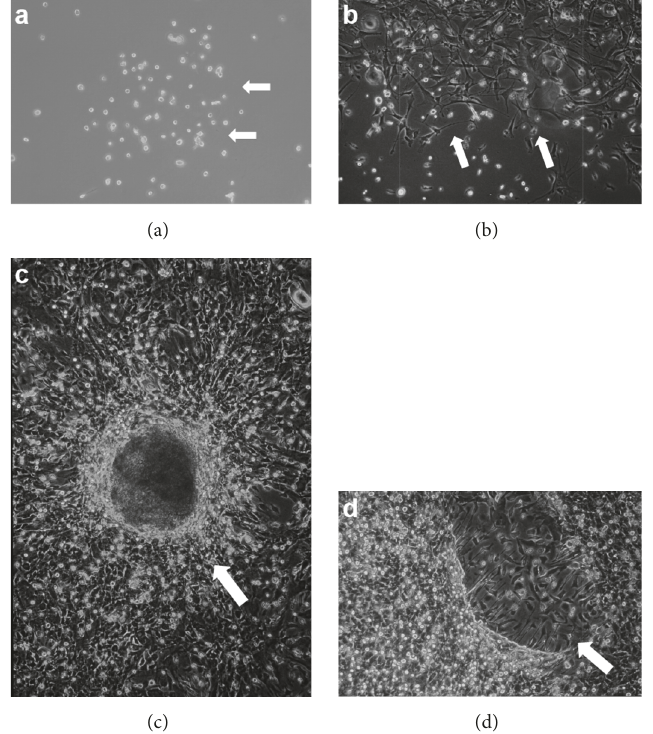
Figure 1: In vitro culture of mouse spleen cells in medium containing 10% FBS. The round cells at the beginning of culture (a). Some of them displayed neural cell-like morphology (b). A bright sphere formed (c) and a large number of cells radiated out (d).